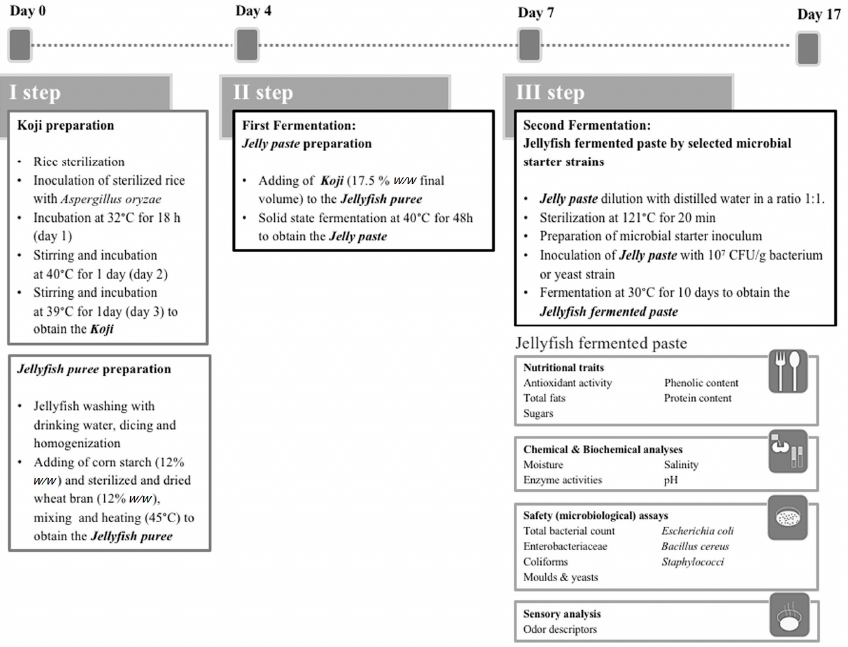
Figure 1. Diagram illustrating the procedure of the new proposed fermentation method for jellyfish- based food production. See also Figure S1.